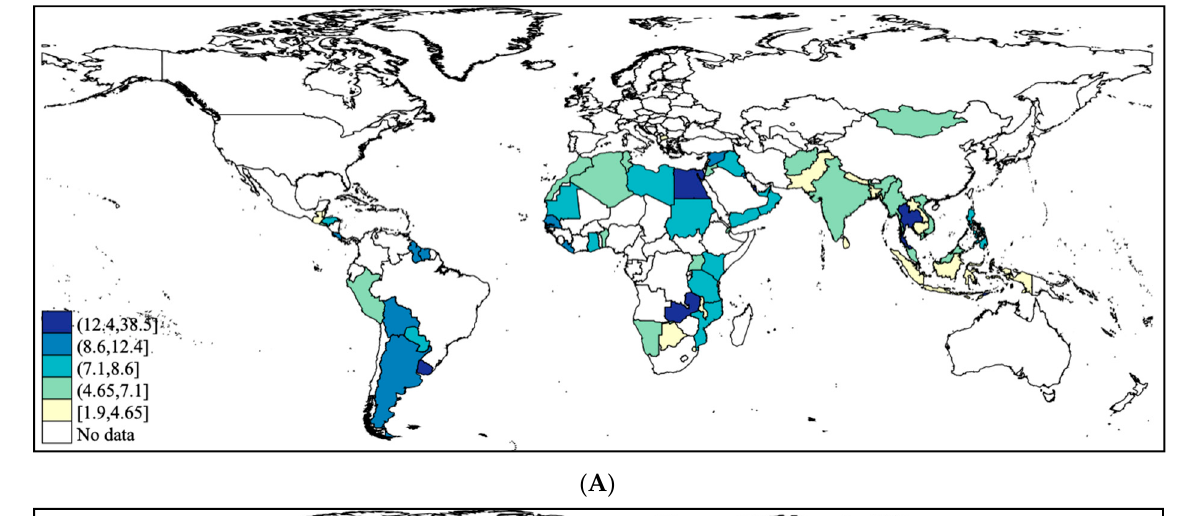
Abbreviation: OR Odds ratio; CI Confidence interval; Country-wise estimates were adjusted for age and sex; a Laos was not included because estimates could not be obtained due to small numbers; b Laos and Northern Macedonia were not included because estimates could not be obtained due to small numbers.